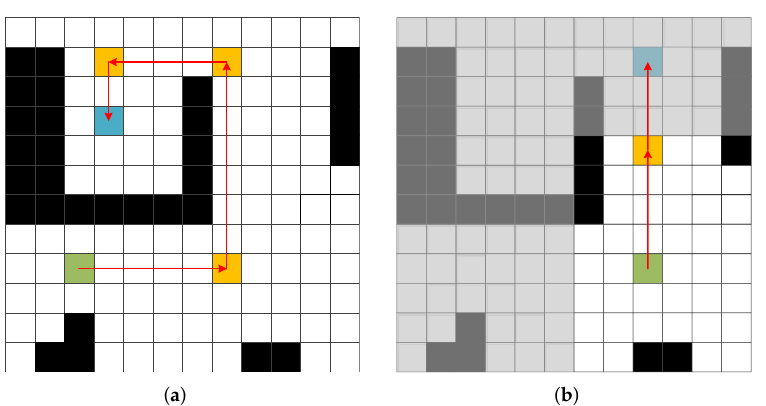
Figure 4. Examples of key points. The left figure shows the first and third types of key points, while the right figure shows the second and third types of key points. The green squares are the current locations of the agent. The blue squares represent the target points, which is also the third type of key points. The red lines represent the optimal path that was generated by A* algorithm and the orange squares are the first or second type of key points. The shaded area represents the unknown range of the agent while the other area represents the known range that has been observed by the